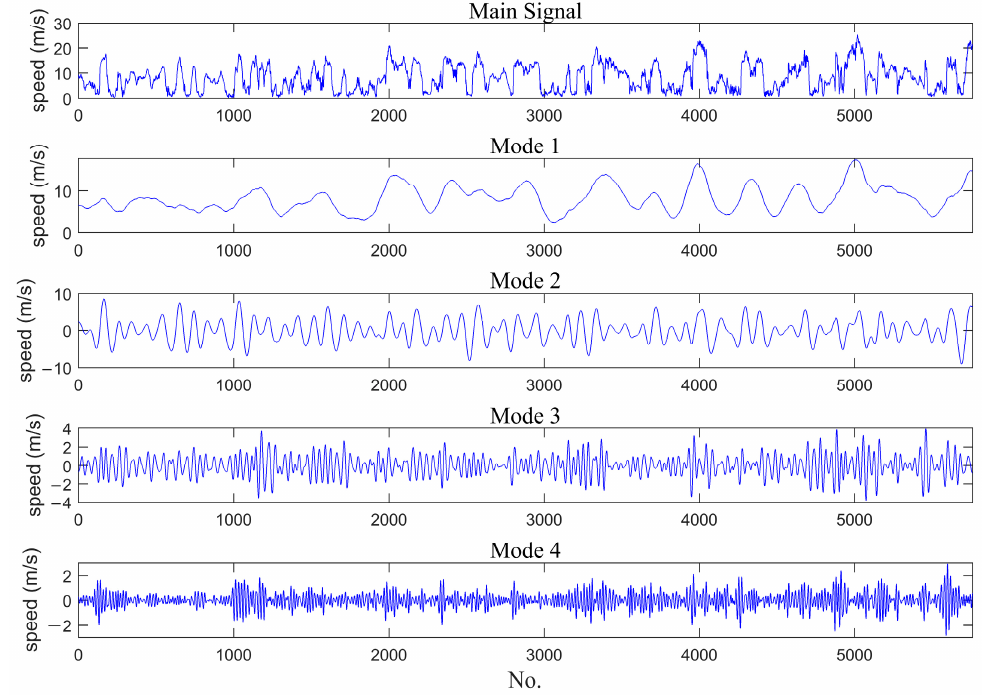
Figure 2. Wind speed signal and the decomposed modes. Energies 2018 , 11 , x FOR PEER REVIEW